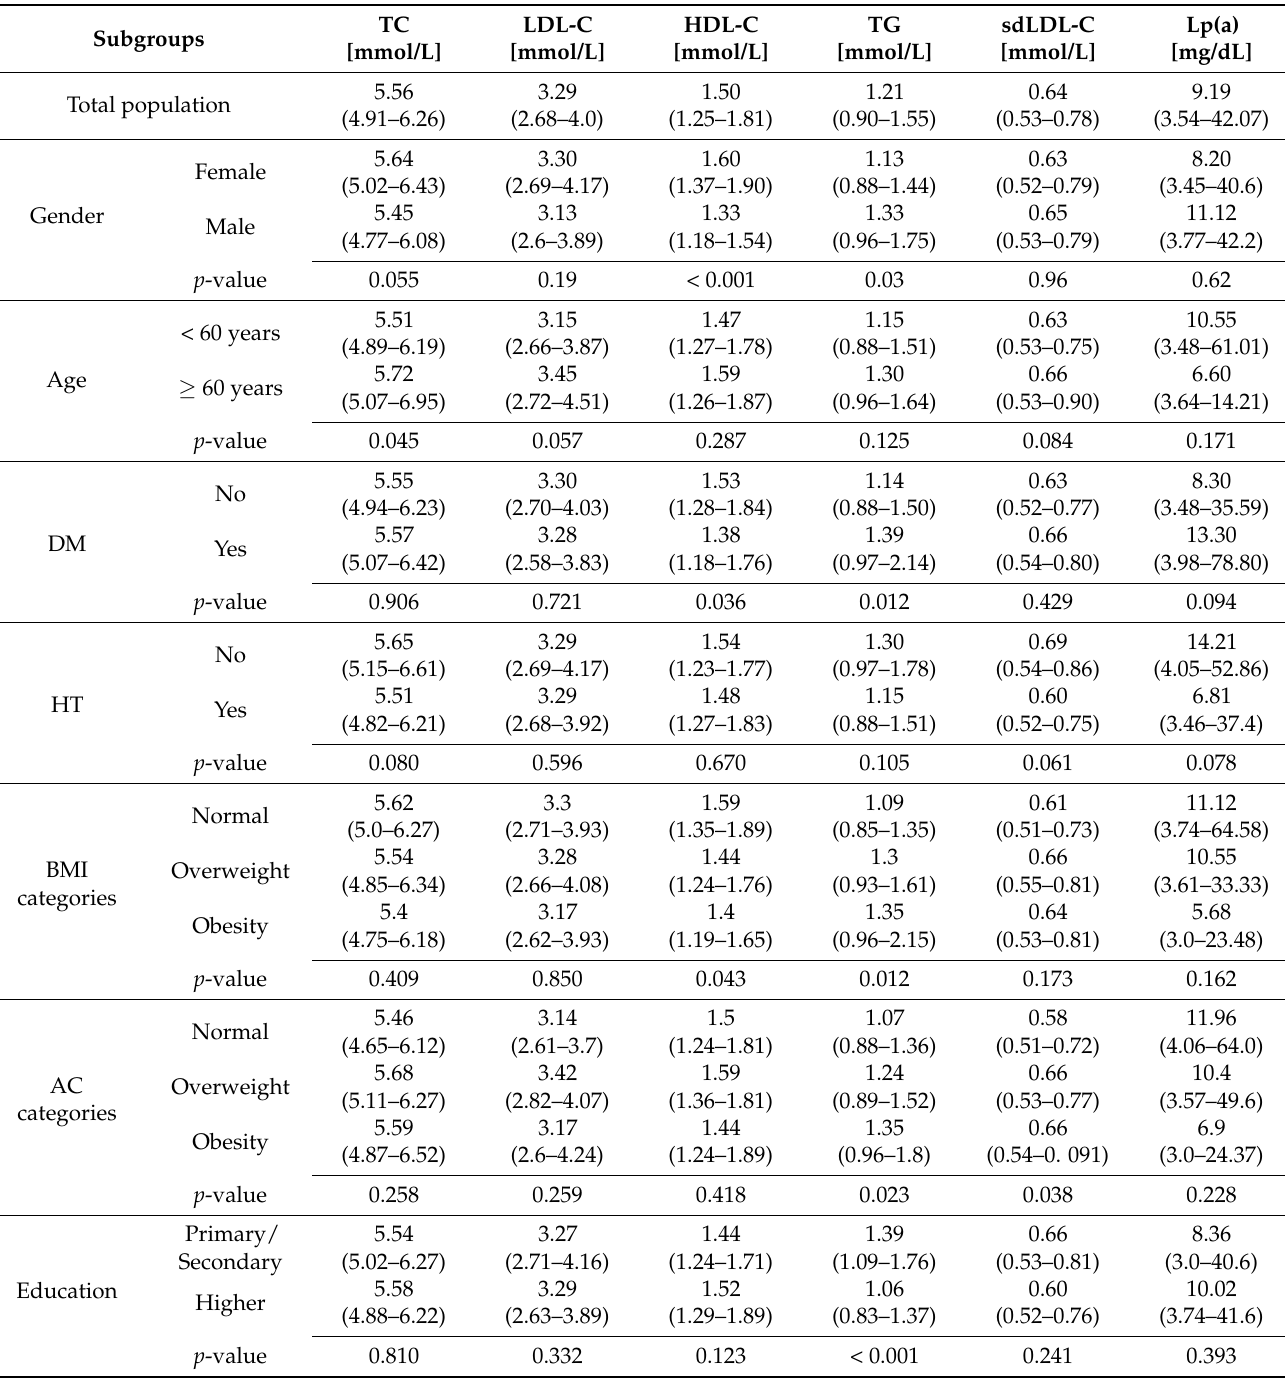
Table 2. Median and interquartile range of analyzed lipid parameters in the general